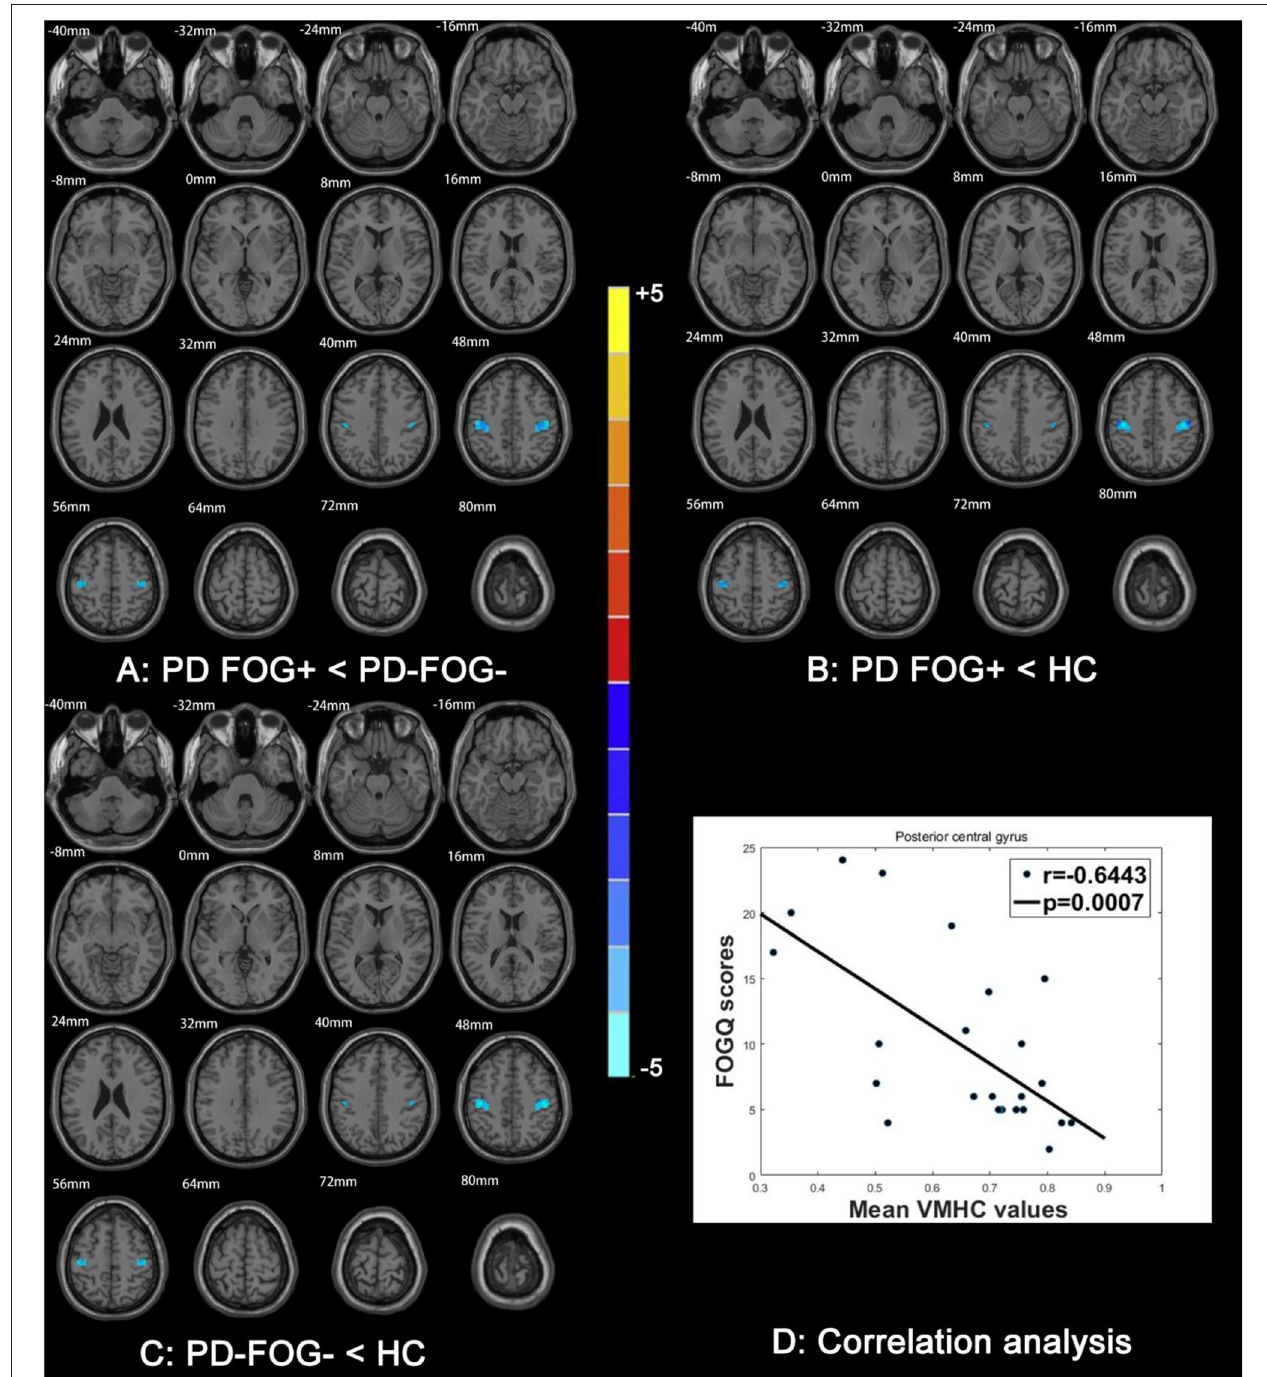
FIGURE 5 | Comparison of VMHC among PD FOG + , PD FOG–, and HC groups. VMHC between (A) PD FOG + and PD FOG–, (B) PD FOG + and HC, and (C) PD FOG– and HC. (D) Correlation analysis between FOGQ scores and VMHC of PCG.